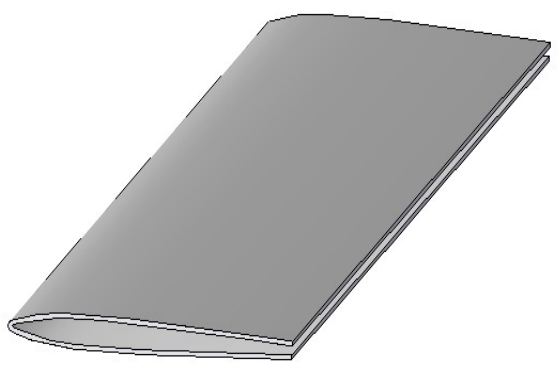
Figure 6. Laminate configuration of the wing (the gap between the upper and the lower wing cambers is exaggerated and not to scale).